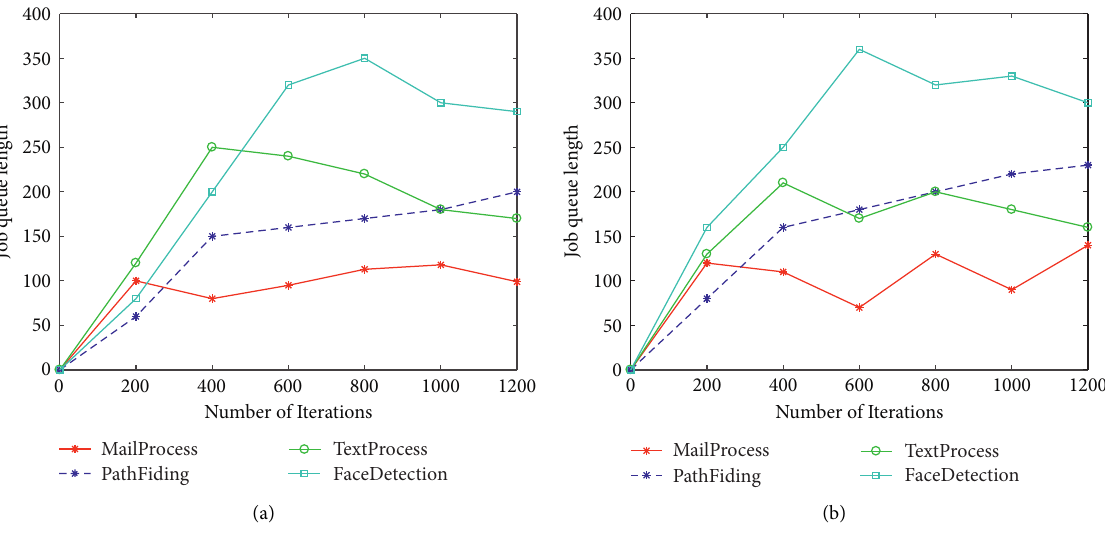
Figure 7: Performance monitoring results. (a) QoS-oriented energy consumption. (b) Traditional energy consumption.